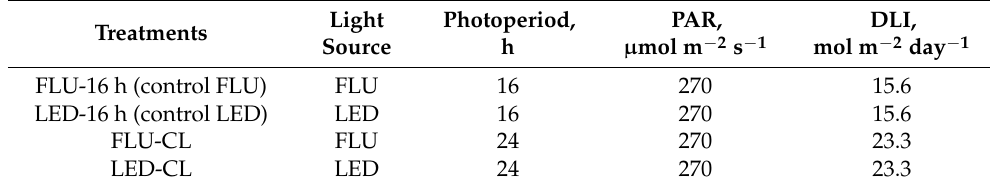
Table 4. Light conditions (light source, photoperiod, light intensity, and daily light integral) of treatments.